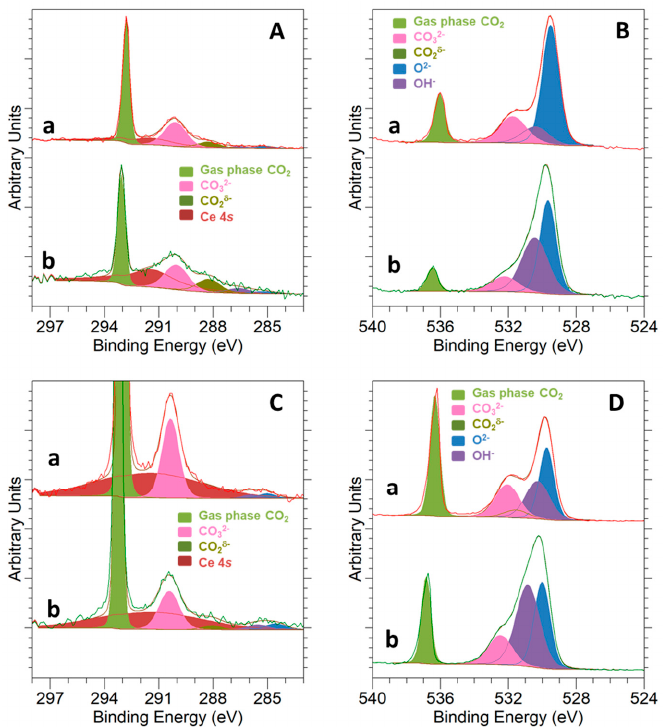
Figure 8. NAP-XPS spectra for C 1 s at KE = 550 eV and KE = 190 eV ( A ) and ( C ) and O 1 s at KE = 550 eV and KE = 190 eV ( B ) and ( D ) corresponding to 5Ni-CeO 2 NCs under 1 mbar CO 2 at temperatures of 250 °C (a) and 500 °C (b).